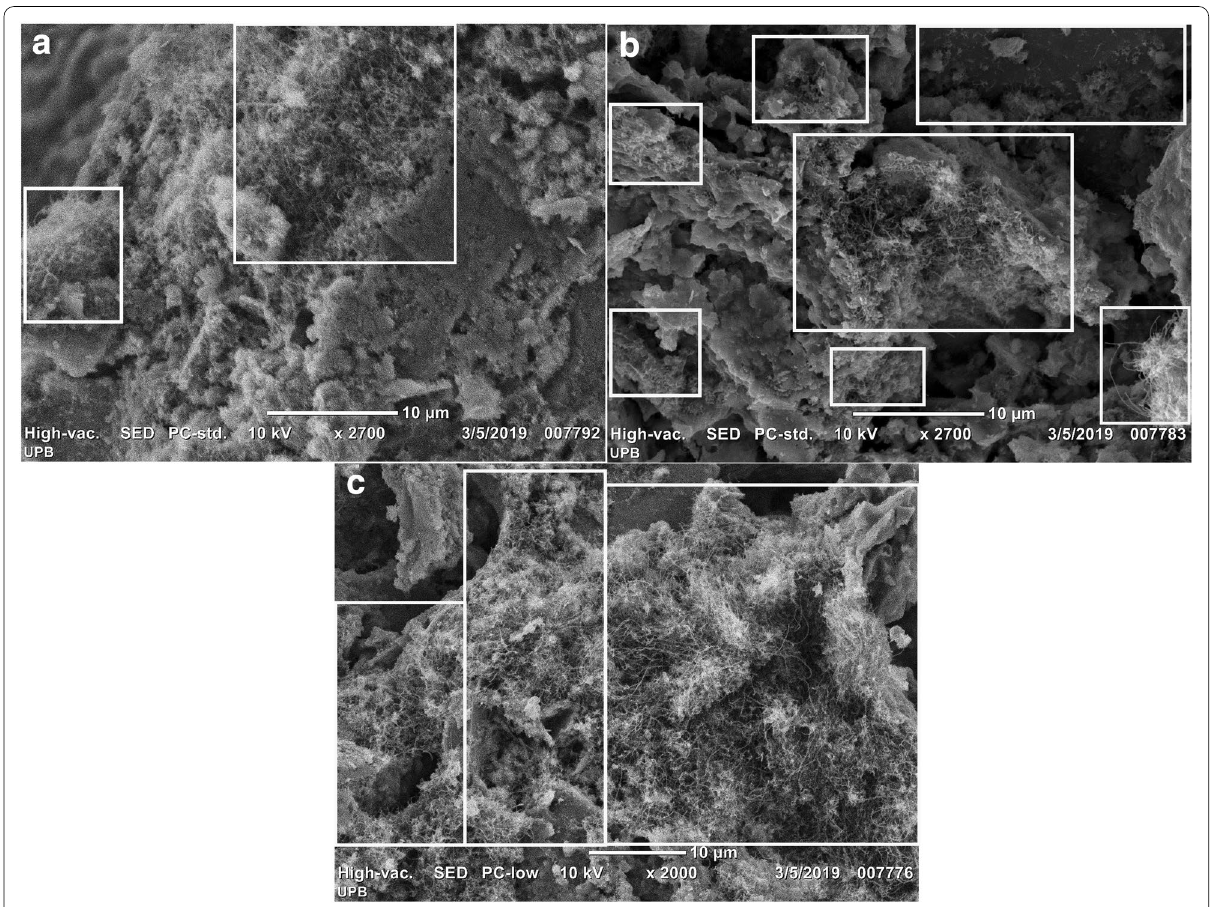
Fig. 7 SEM images for samples: a 0.2 % wt (2700X), ( b ) 0.5 % wt (2700X) and ( c ) 0.8 % wt